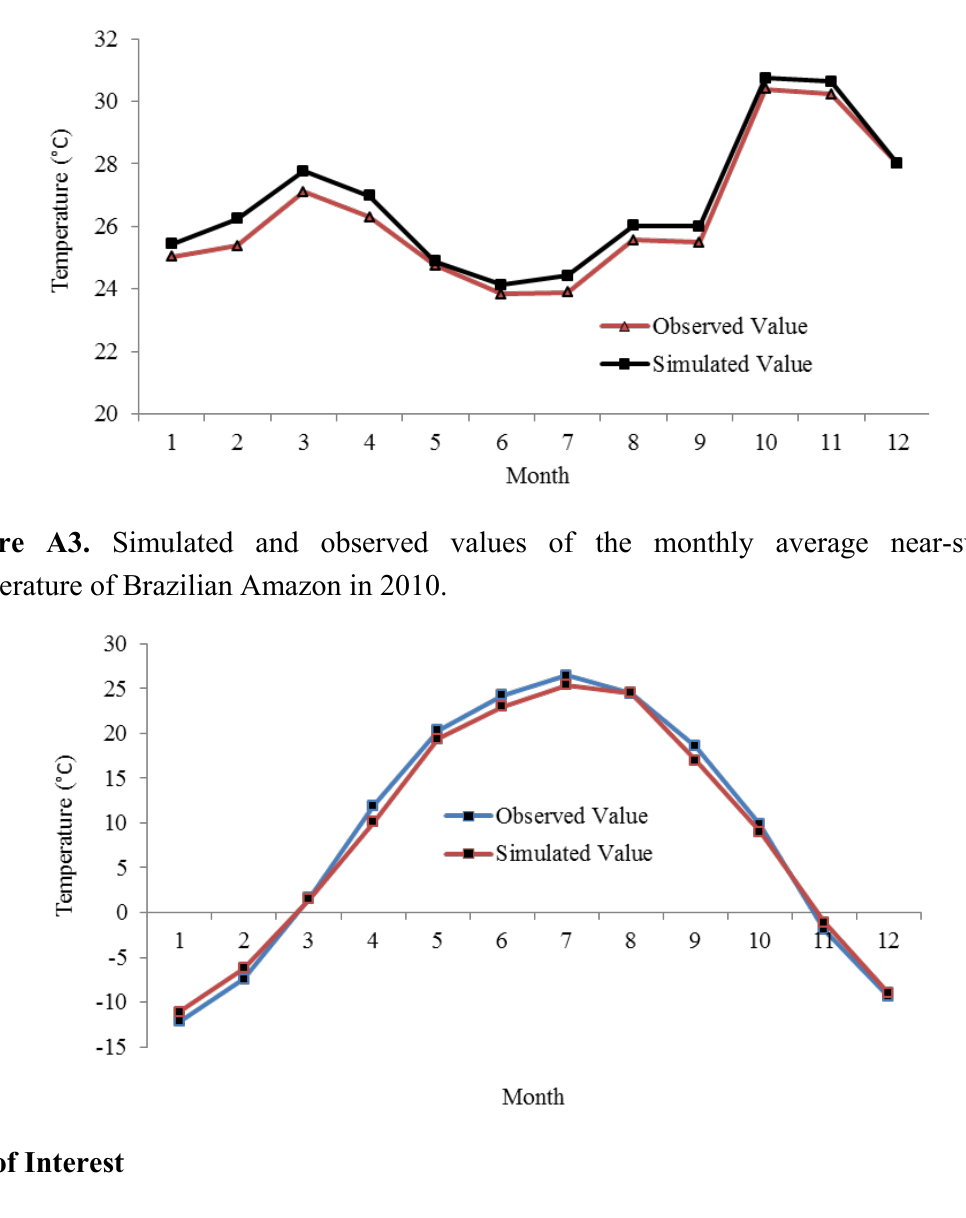
Figure A2. Simulated and observed values of the average near-surface temperature of Brazilian Amazon in 2010.